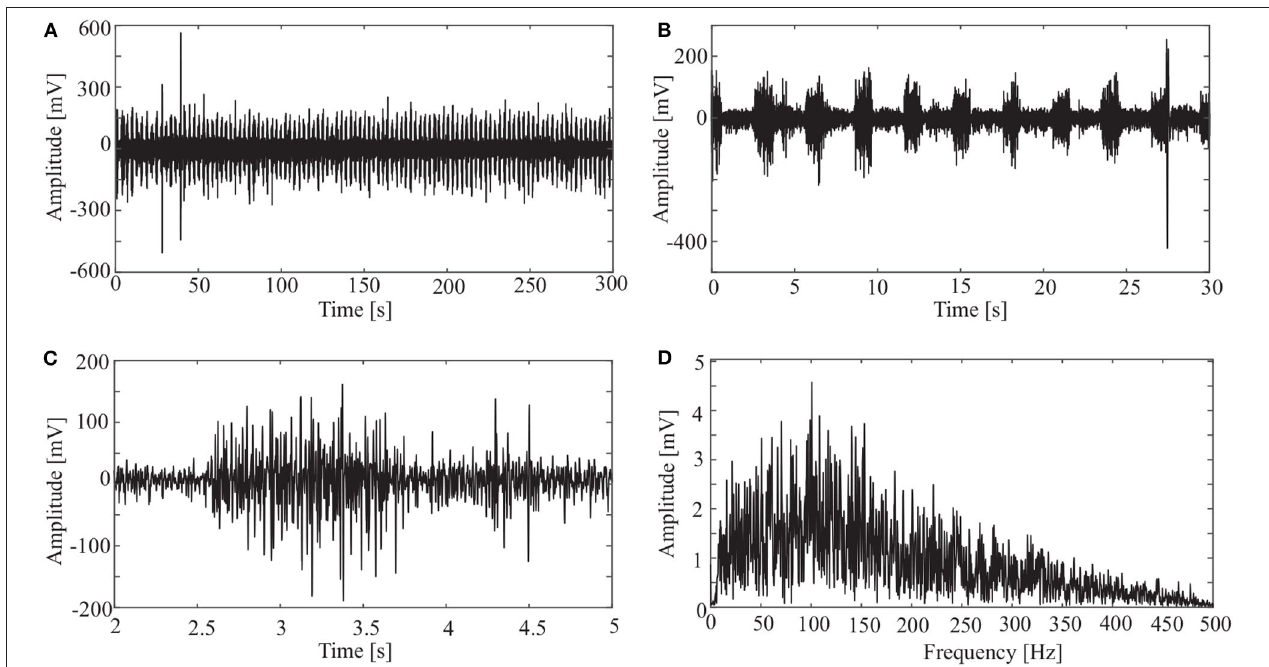
FIGURE 3 | Original sEMG signal and processing result: (A) sEMG for the whole length, (B) sEMG for the first 30s, (C) sEMG from 2 to 5s, and (D) spectrum of sEMG from 2 to 5s.